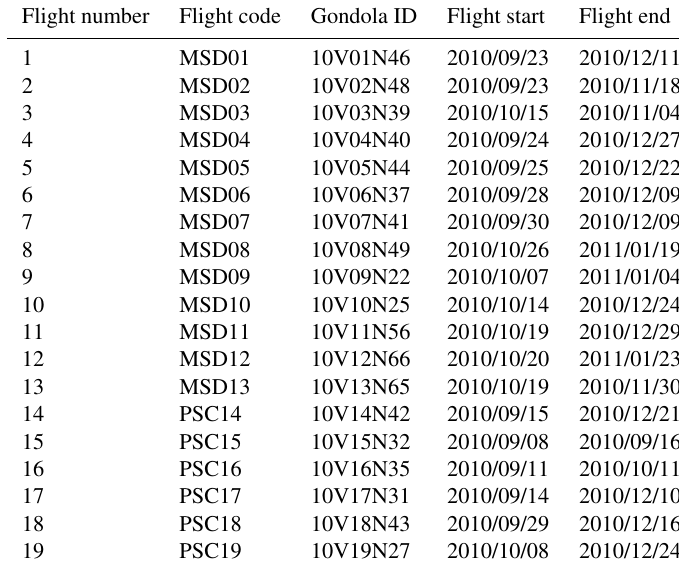
Table 1. Concordiasi balloon flights over Antarctica in September 2010 to January 2011. Flight number Flight code Gondola ID